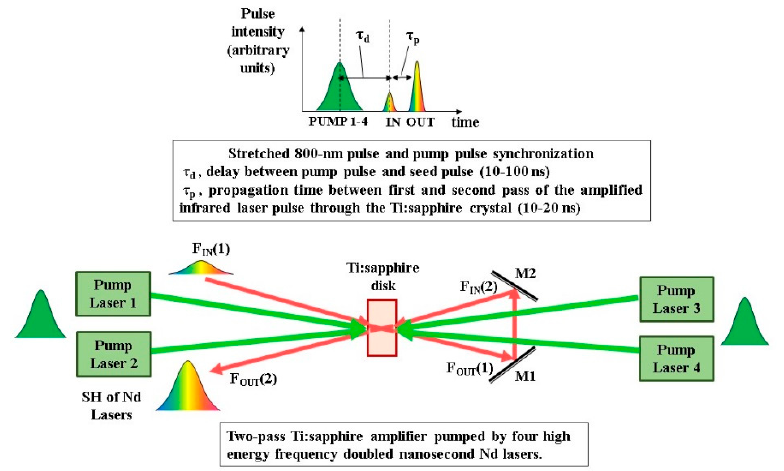
Figure 9. The typical configuration of a Ti:sapphire high energy multi-pass amplifier.